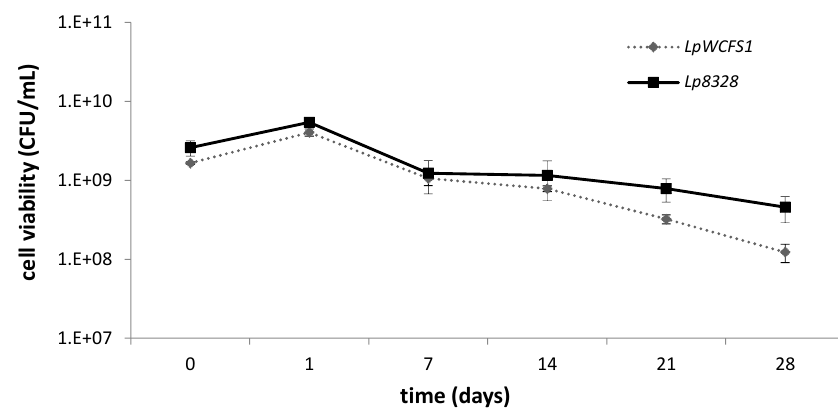
Figure 2. Cell viability of L. plantarum strains used to produce yogurt at Time 0 (initial inoculum prior to the start of the fermentation), 1, 14, 21 and 28 days of storage at 4 °C. LpWCFS1, L. plantarum WCFS1; Lp8328, L. plantarum CECT 8328. Values represent the mean ± the standard deviation (SD) of two different